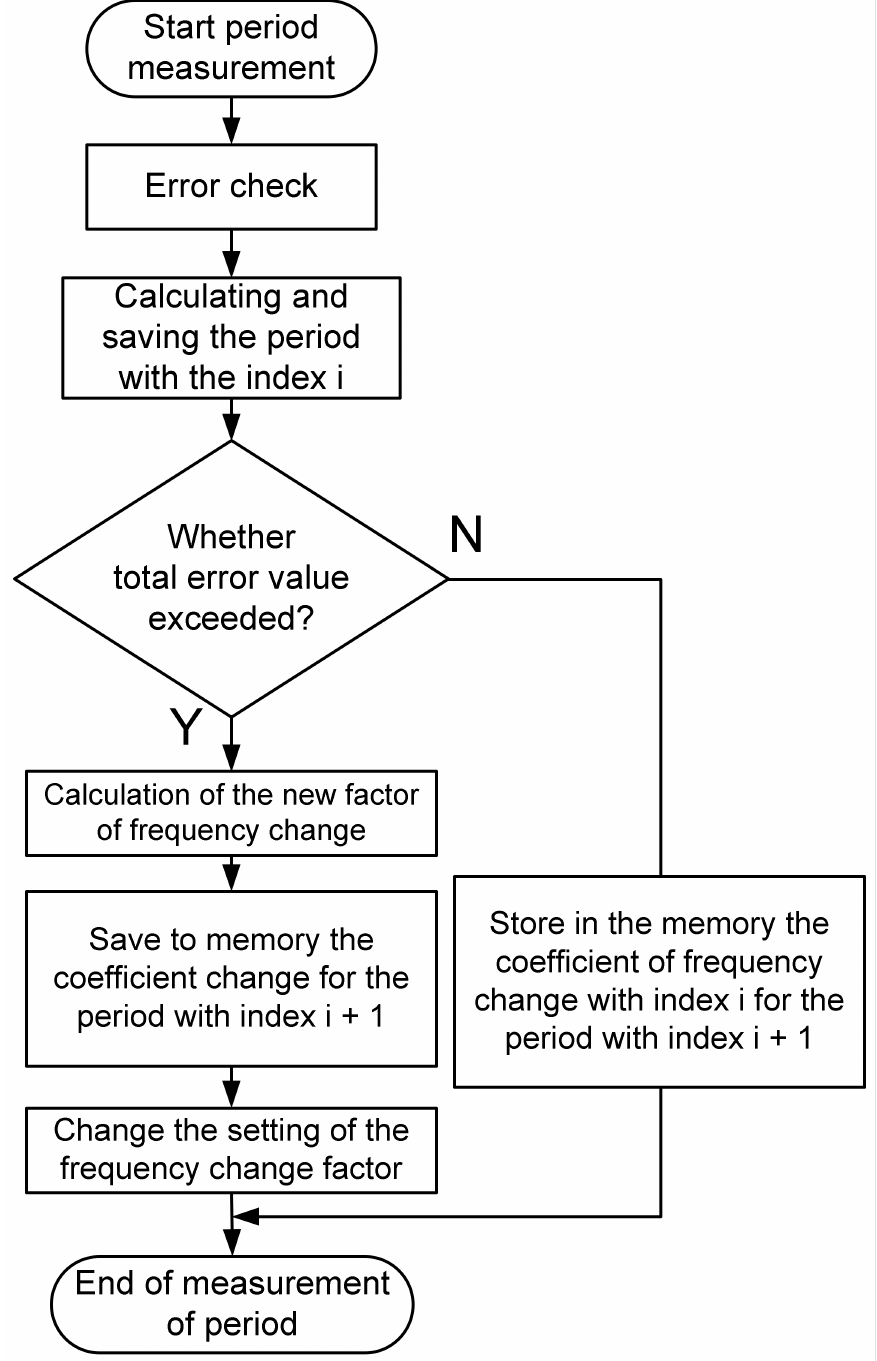
Figure 9. Work algorithm of the f/N converter containing a microprocessor system of satisfactory